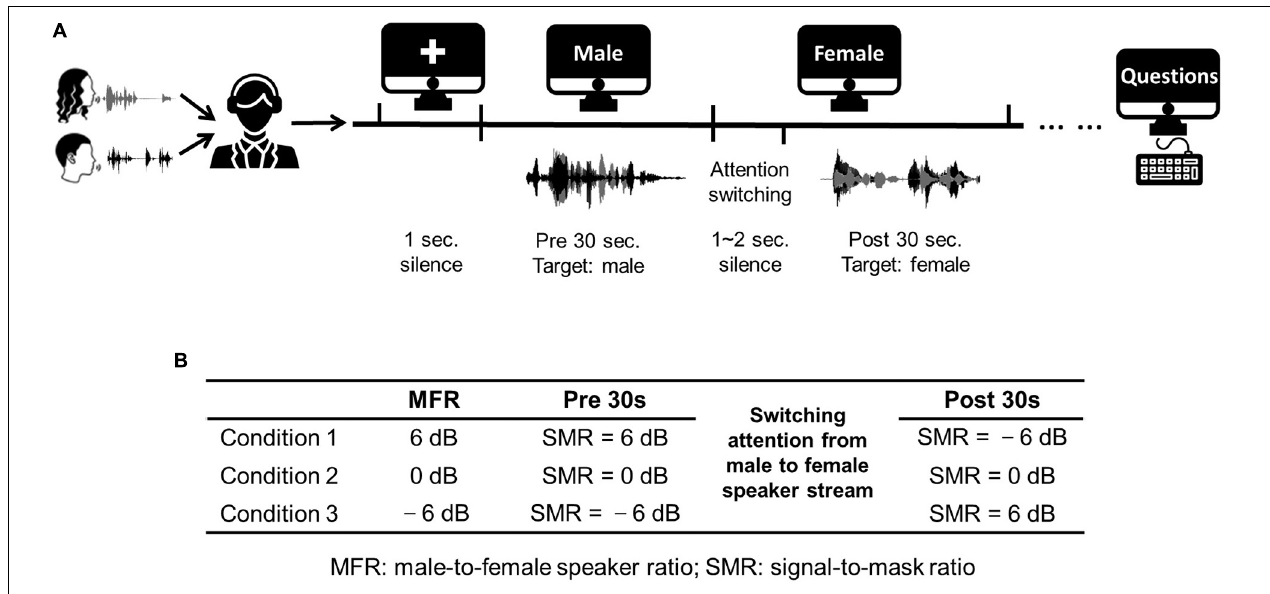
FIGURE 1 | (A) An illustration of the experimental procedure. (B) Three conditions used in this study. Three conditions fixed the MFR levels at 6, 0, and –6 dB, and the SMR level were changed in the first half and the latter half with the switching of the auditory attention from the male to the female speaker streams. The icons used in (A) obtained from